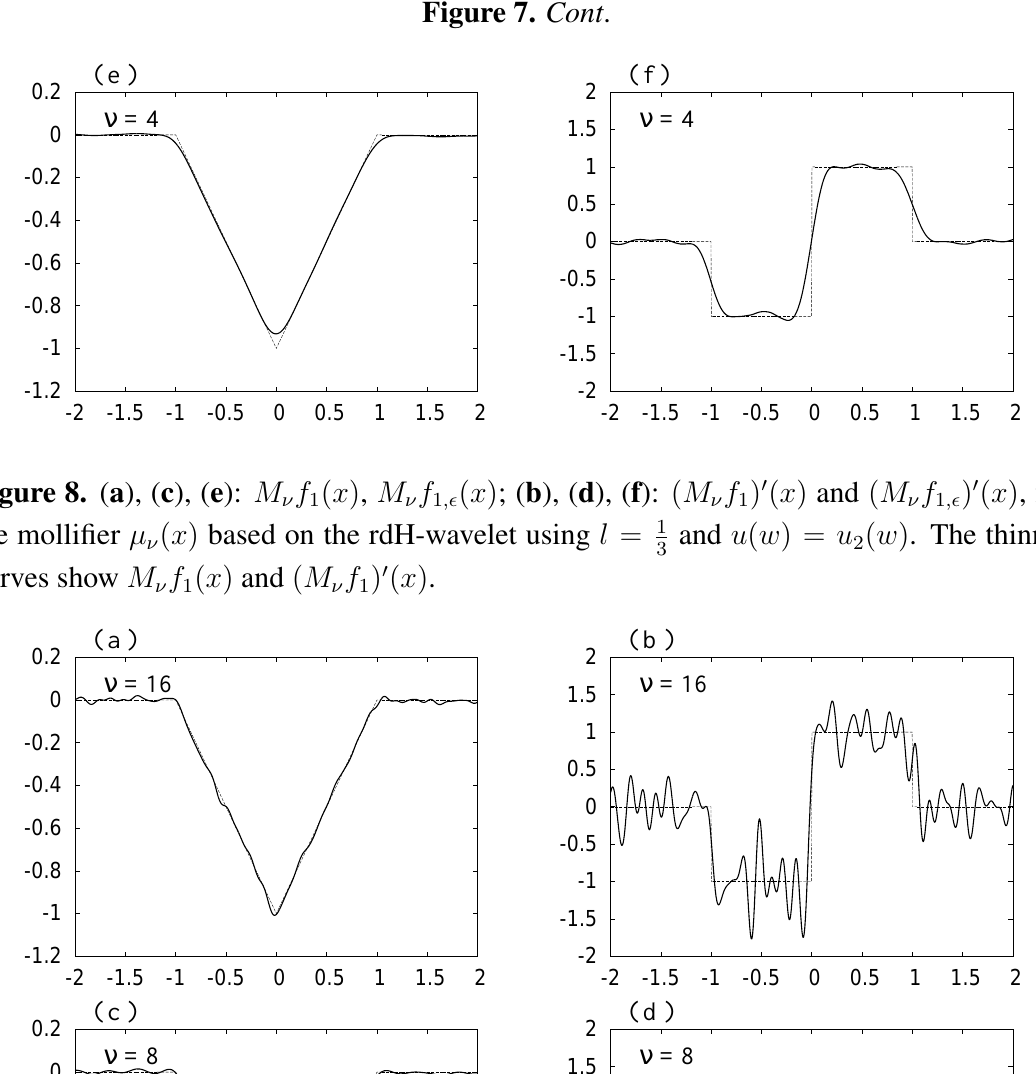
f ) ′ ( x ) , for ν 1 ,ϵ ( w ) . The thinner 2